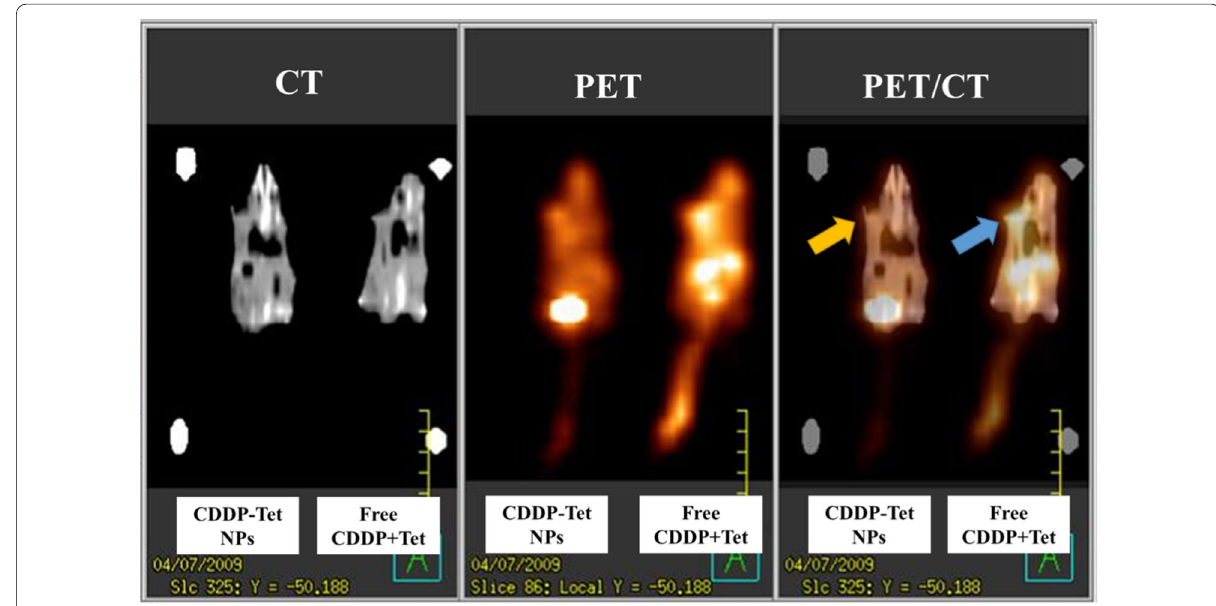
Fig. 9 Male ICR mice bearing a subcutaneous H 22 tumor at the left axillary (arrows). CT, PET and fused PET/CT images are arranged in the figure from left to right. Tumor metabolic rate in free CDDP plus Tet group (blue arrow) was significantly higher than NPs group (yellow